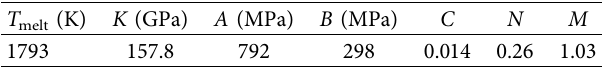
Table 5: Hugoniot data of reactive materials and fitting results of JWL equation